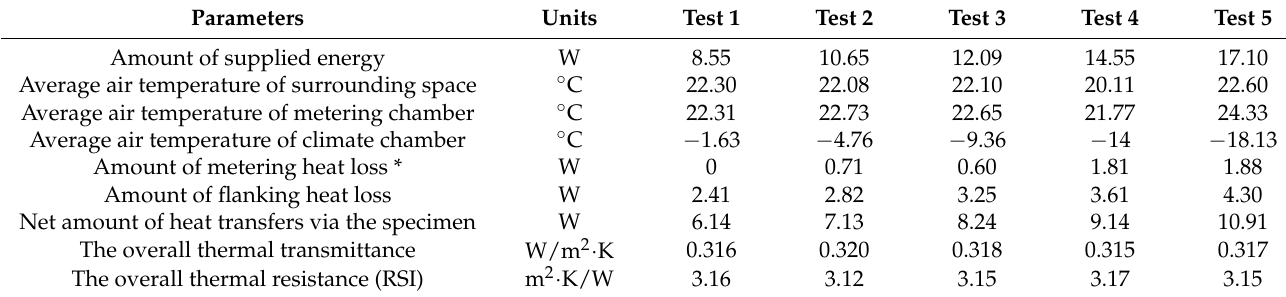
Table 6. Thermal properties of the tested wall assembly assessed